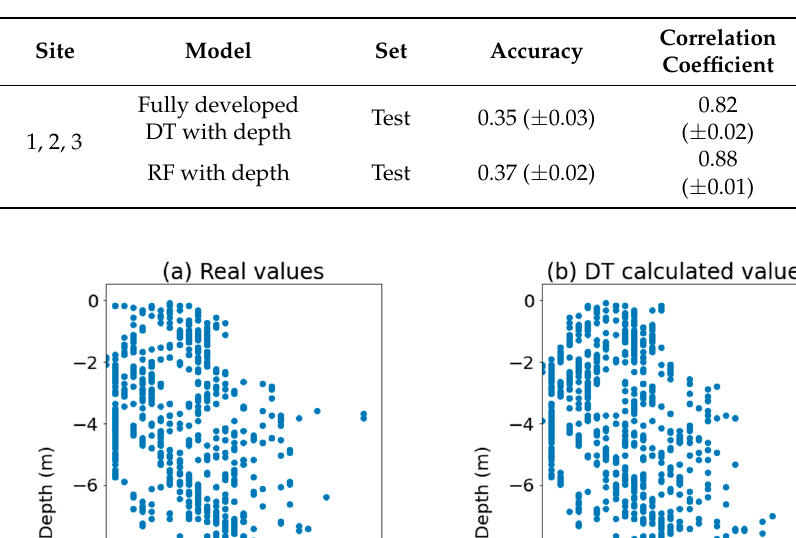
Table 15. Correlations obtained for the set of sites 1, 2 and 3.